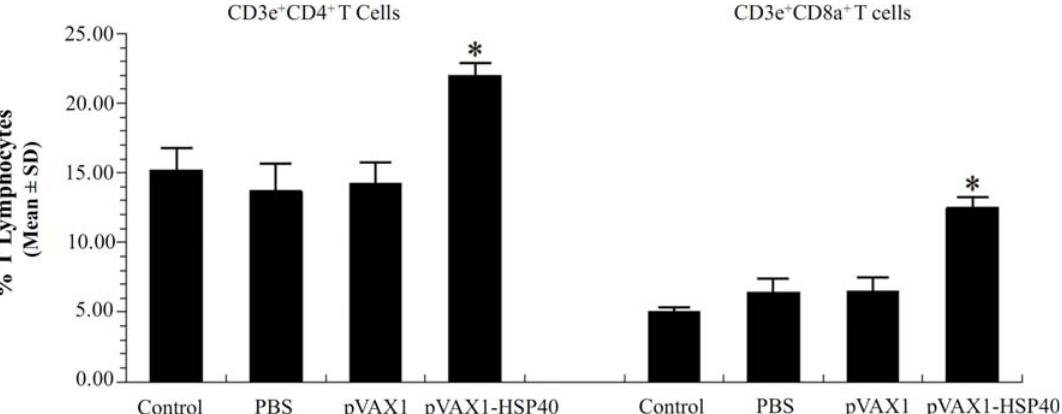
Figure 5. Flow Cytometry analysis of the proportion of T lymphocyte subclasses in mouse spleen. The CD3e + CD4 + T- and CD3e + CD8a + T- lymphocytes in spleen of pVAX1-HSP40-immunized mice were increased significantly compared with that of mice in the control groups ( p < 0.05). No significant difference was detected among the mice in the three control groups ( p > 0.05).